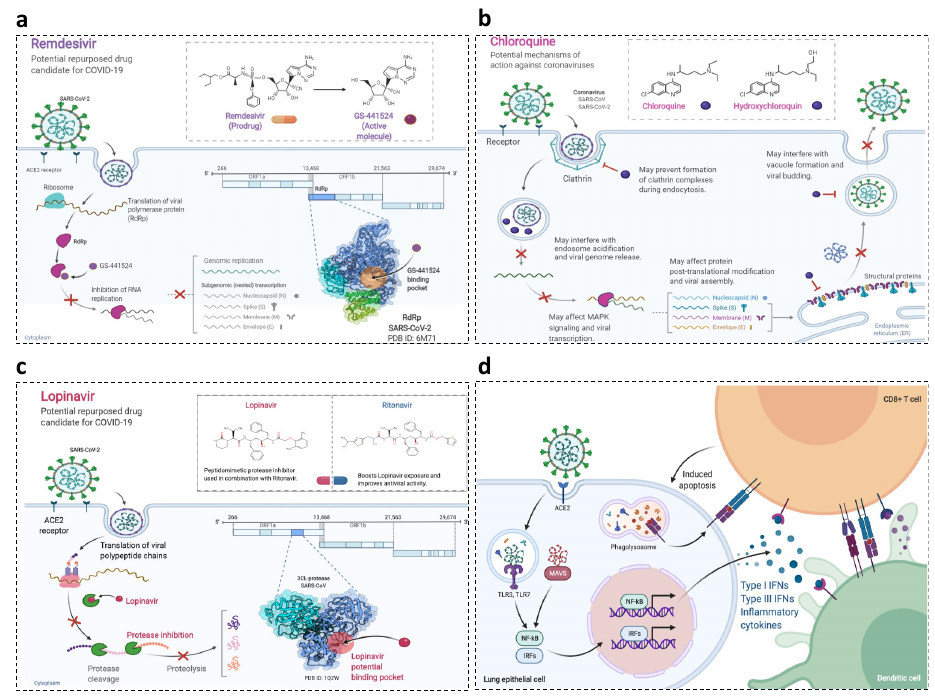
Figure 2. Mechanism of action of ( a ) Remdesivir, ( b ) Chloroquine, ( c ) Lopinavir and ( d ) Immunomodulators on the SARS-CoV-2 virus. Illustrations were made with BioRender.